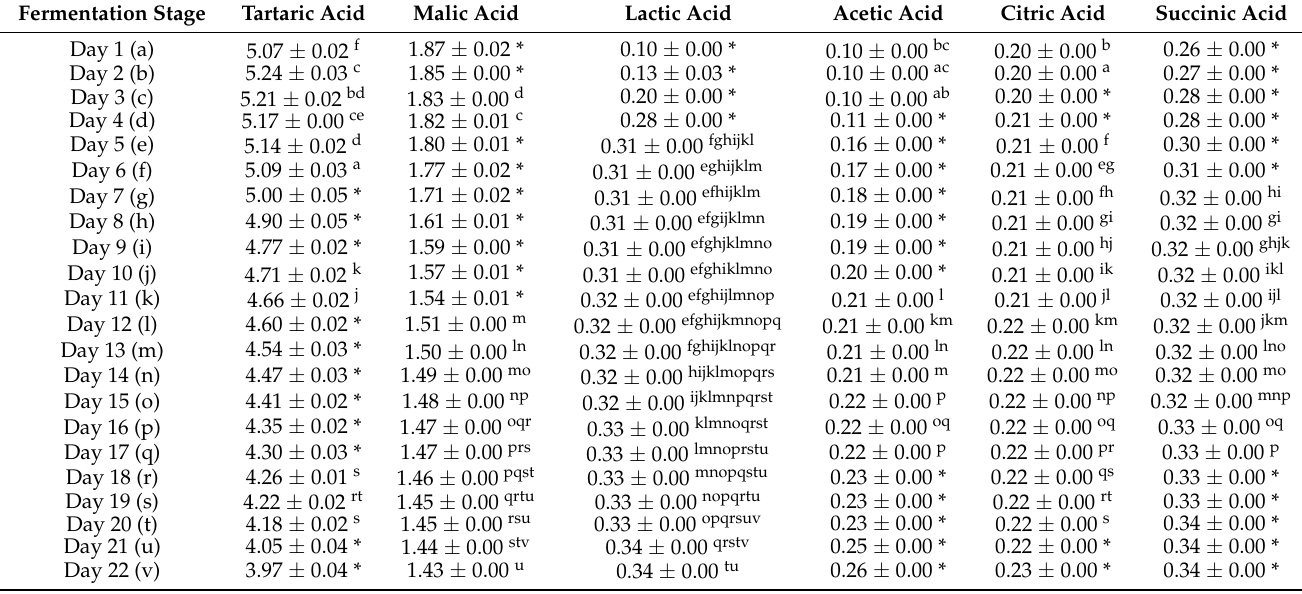
Table 4. Evolution of main organic acids during alcoholic fermentation of V3 variant (g/L).